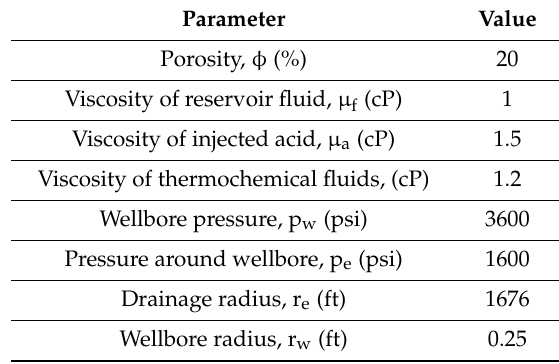
Table 1. Reservoir, well, and fluid properties for liquid formation.